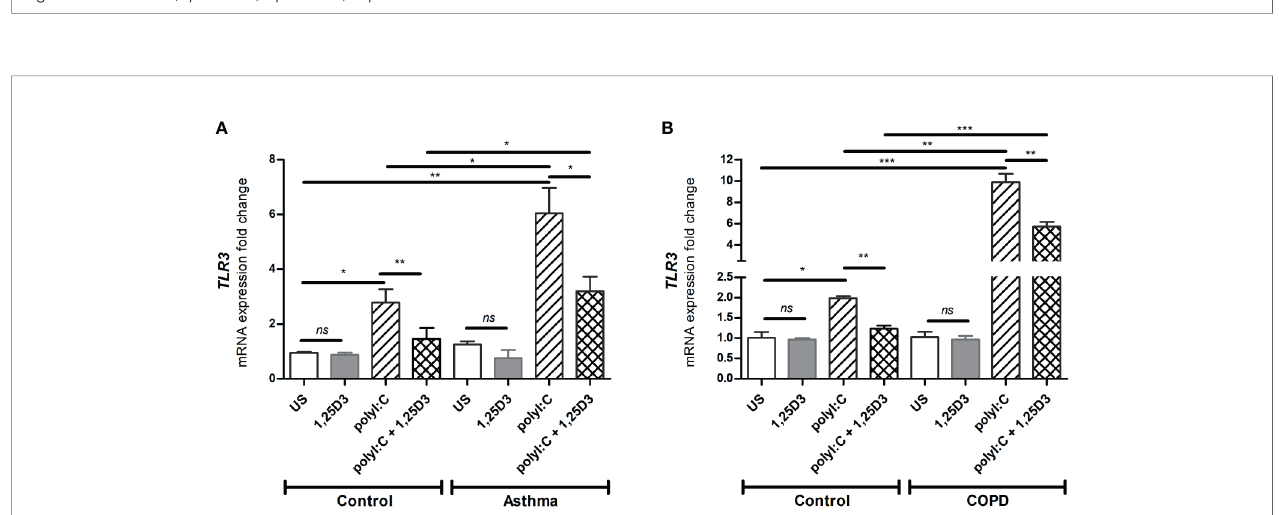
FIGURE 2 | mRNA expression of TLR3 in asthma (A) and COPD (B) compared to healthy control groups. n = 4 asthma, n = 3 healthy controls, n = 4 COPD, and n = 3 healthy control smokers. qRT-PCR data is representative of two independent experiments. One way ANOVA using Newman-Keuls multiple comparison test were performed to assess statistical signi fi cance between groups. Mean ± SE; ( ns ) p > 0.05, no signi fi cant difference, * p < 0.05, ** p < 0.01, *** p < 0.001.